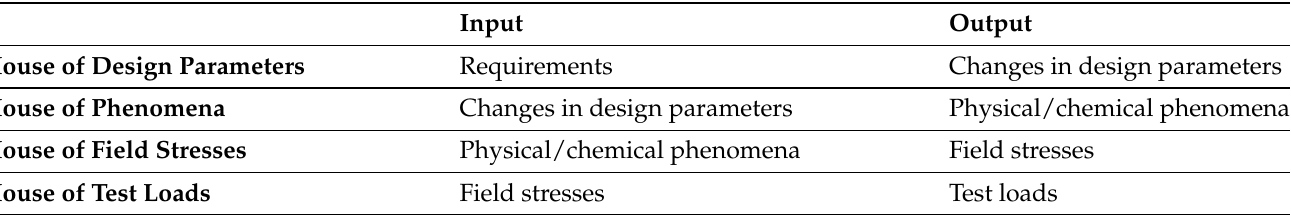
Table 1. The inputs and outputs of the proposed SND method which show the logic of the relationship between the Houses of